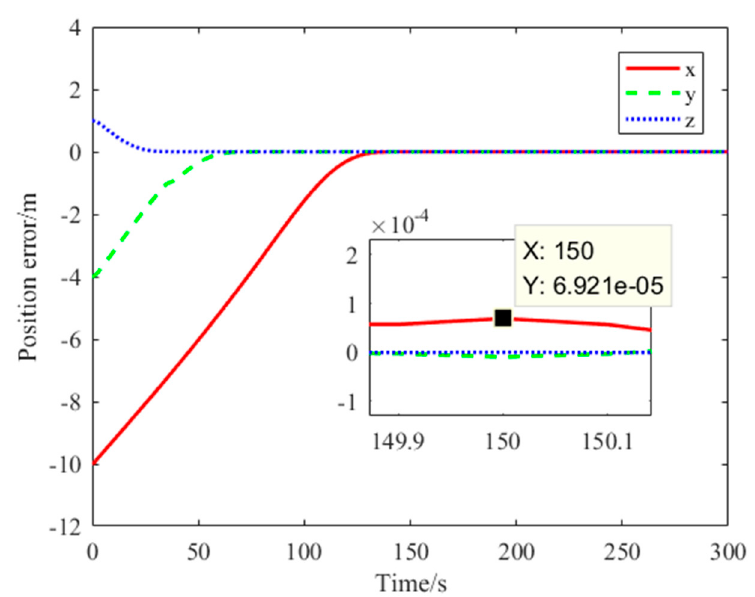
Figure 7. Time response of position error r − r f .